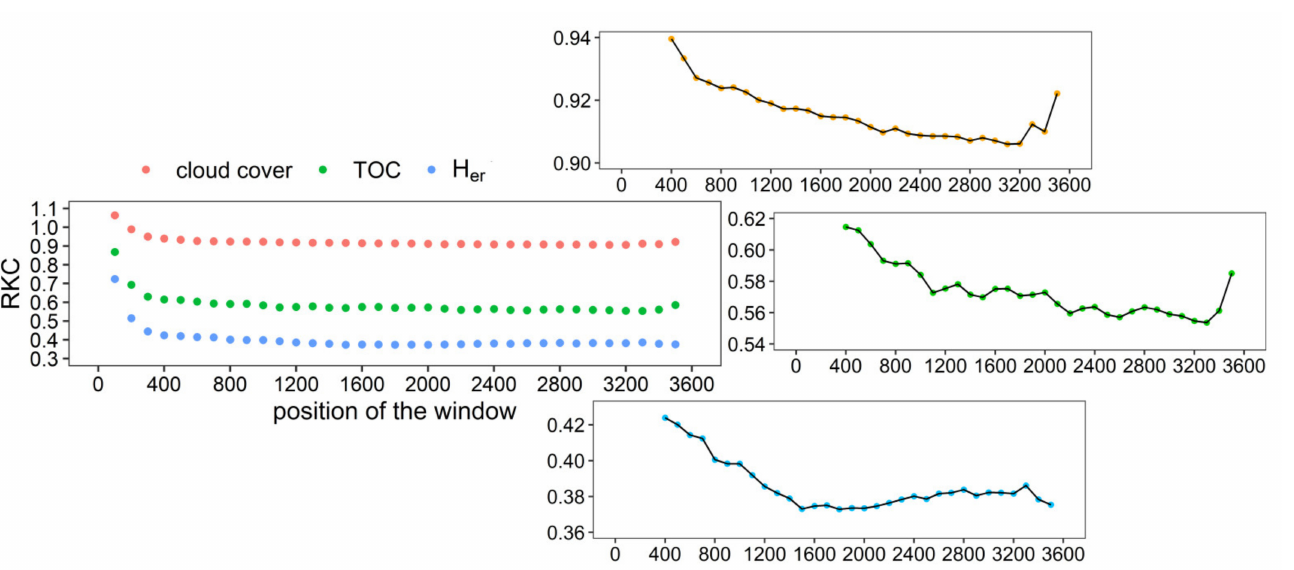
Figure 5. The running KC (RKC) time series for H er (blue), TOC (green), and cloud cover (orange) for a fixed window of 100.